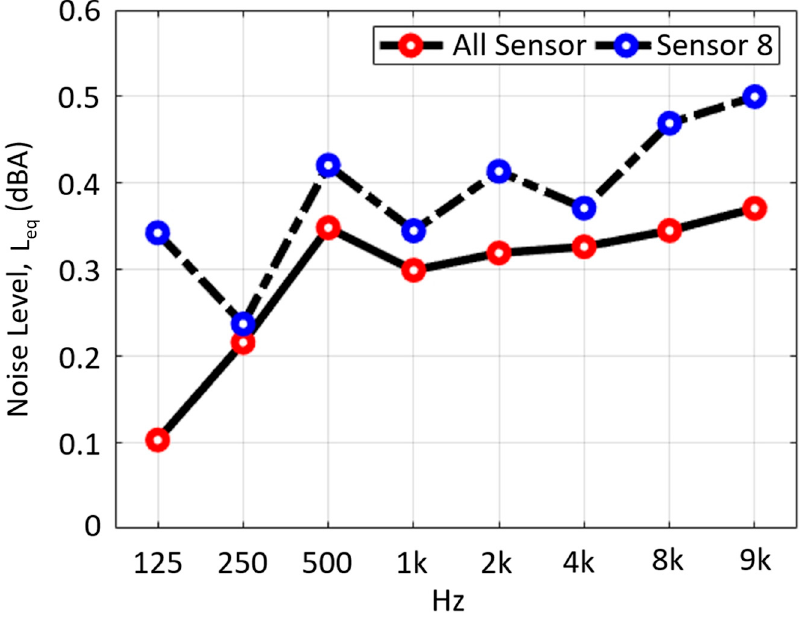
Figure 8. Morning and night noise error data vs. frequency (all sensor avg. vs. sensor 8).